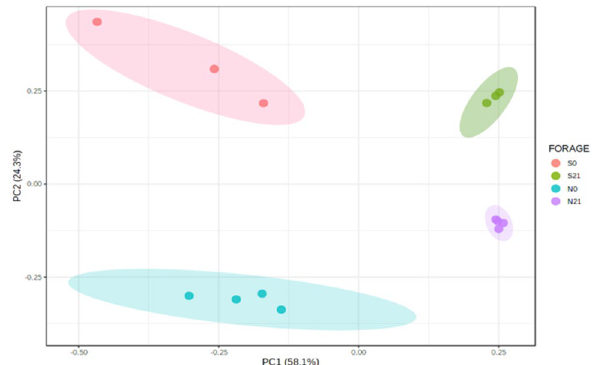
Figure 9. Principal coordinate analysis (PCoA), calculated using the Euclidean distance algorithm between fresh crops and silage for sweet corn and Napier based on KEGG functional profiles predicted by Tax4Fun. Coloured dots represent different forage crops (S0, Fresh sweet corn; S21, Sweet corn silage; N0, Fresh Napier; N21, Napier silage).